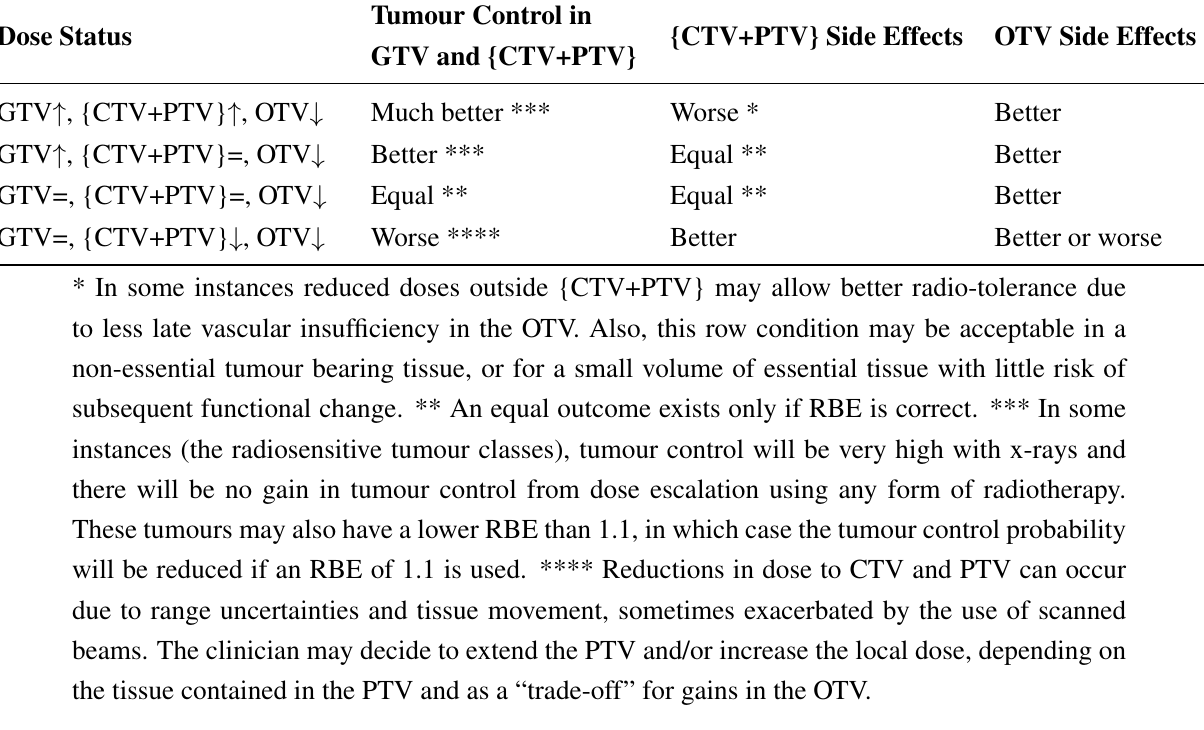
Table 1. Dose status for each ICRU volume and likely clinical outcome changes produced by CPT compared with MXT, where ↑ is an increased dose, = is the “equivalent” dose and ↓ is a reduced dose for the CPT. OTV is the volume of the body outside the PTV. Tumour Control in Dose Status {CTV+PTV} Side Effects OTV Side GTV and {CTV+PTV}